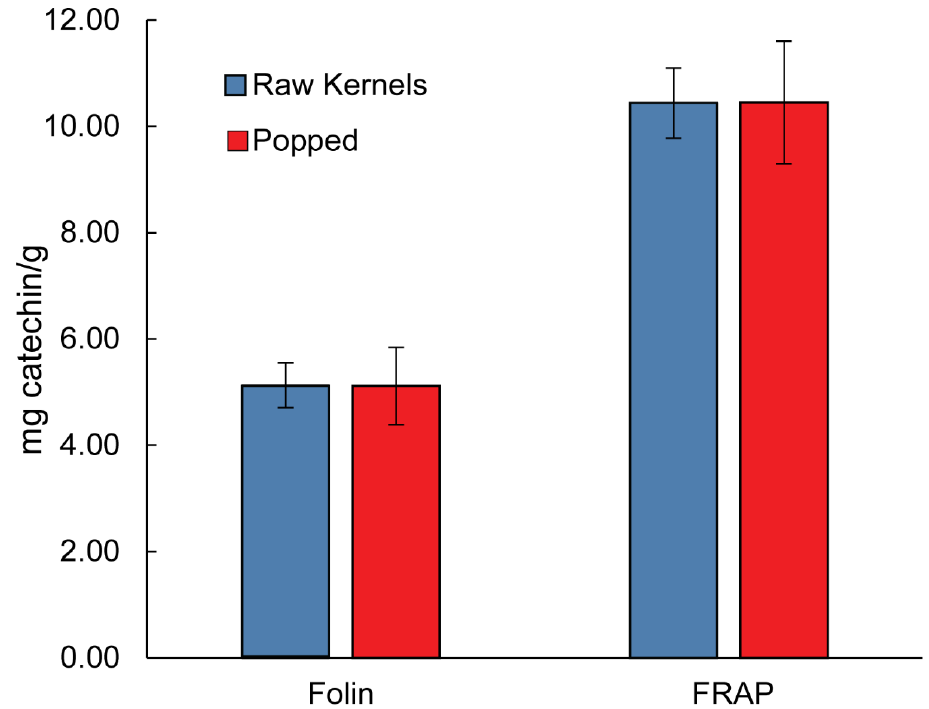
Figure 3. Average total phenolic content by Folin and antioxidant capacity by FRAP (mg catechin/g) of hydrolyzed raw and popped popcorn kernels. There are no significant differences between the popped and raw kernels. (n = 3, p>0.05).